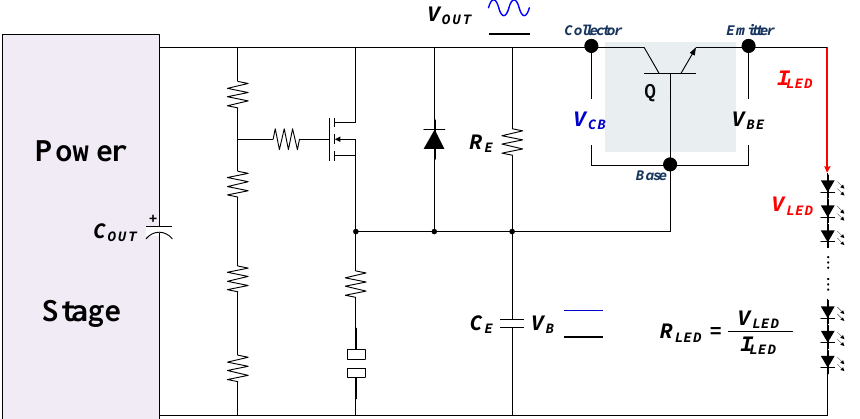
Figure 3. The output ripple eliminator.